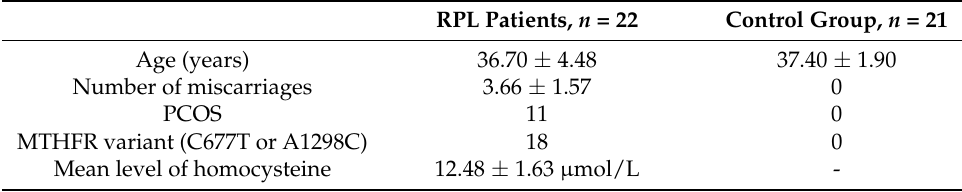
Table 1. Characteristics of study and control